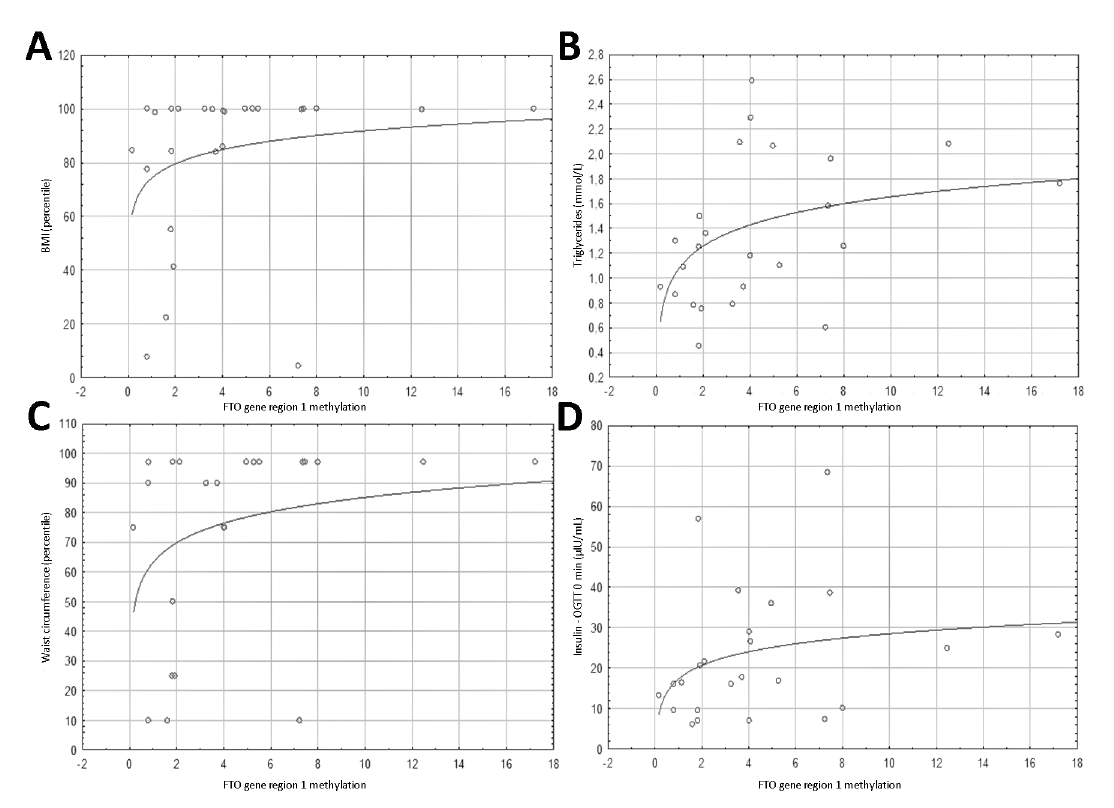
Figure 1. Plots presenting the distribution of the studied parameters depending on the level of FTO region 1 methylation [%]. ( A ) BMI percentile; ( B ) triglyceride concentrations [mmol/L]; ( C ) waist circumference percentile; ( D ) insulin—OGTT 0 min (µIU/mL).